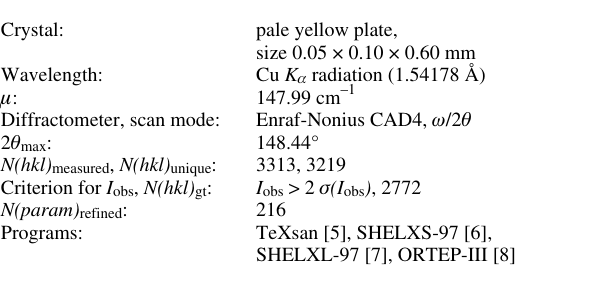
Table 1. Data collection and handling.